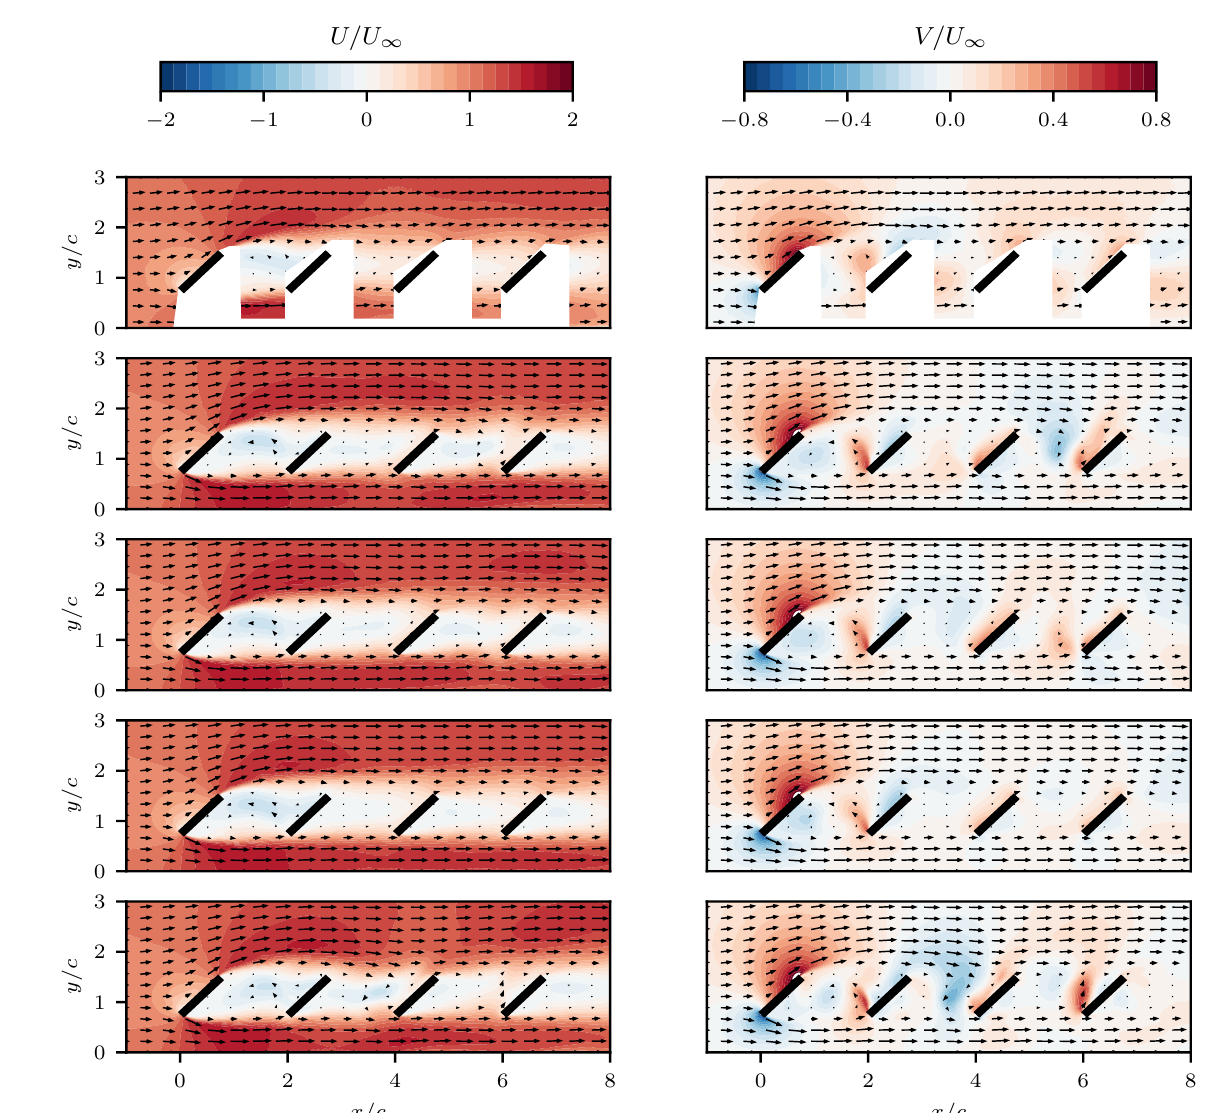
Figure 4. Contour map of the average horizontal ( left column ) and vertical ( right column ) velocity components. From top to bottom, rows refer to experimental measurements, transitional SST, k - ω SST, k - (cid:101) and RSM. The horizontal and vertical dimensions are normalised with respect to the panel chord length c . The velocity magnitude is normalised with respect to the inlet free-stream velocity measured in the wind tunnel. Solar panels are shown in black color. For experimental measurements, areas below the solar panels in which the laser illumination was not sufficient are blanked in white